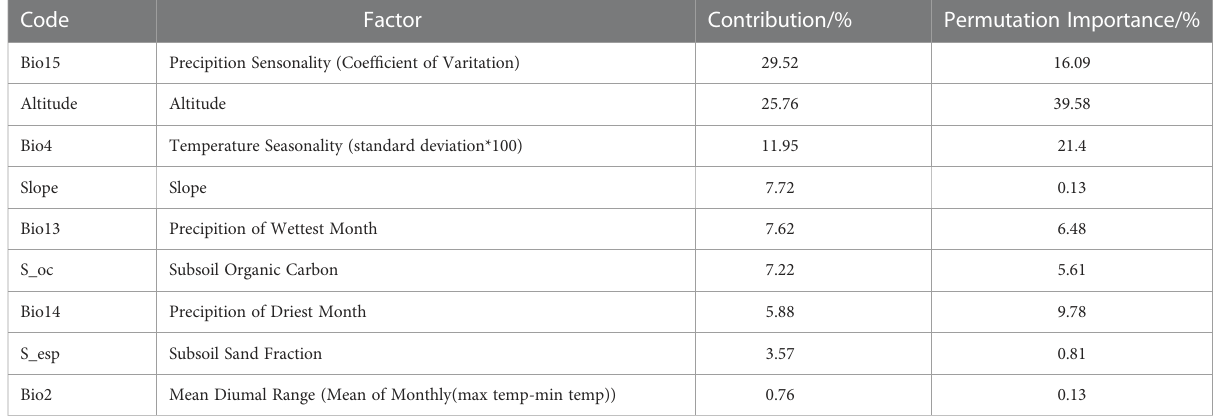
TABLE 2 Contribution rate of environmental variables and importance of